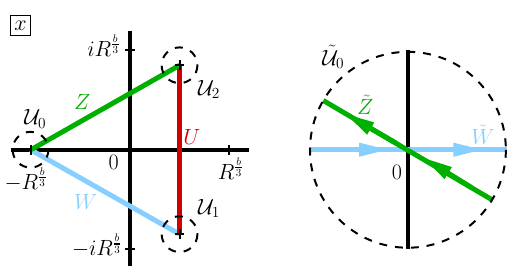
Figure 4. In this (cid:12)gure we illustrate our basis choice for the cycles in the x - and y -plane for the f -tube. ~ is the inverse image in the double cover of U 0